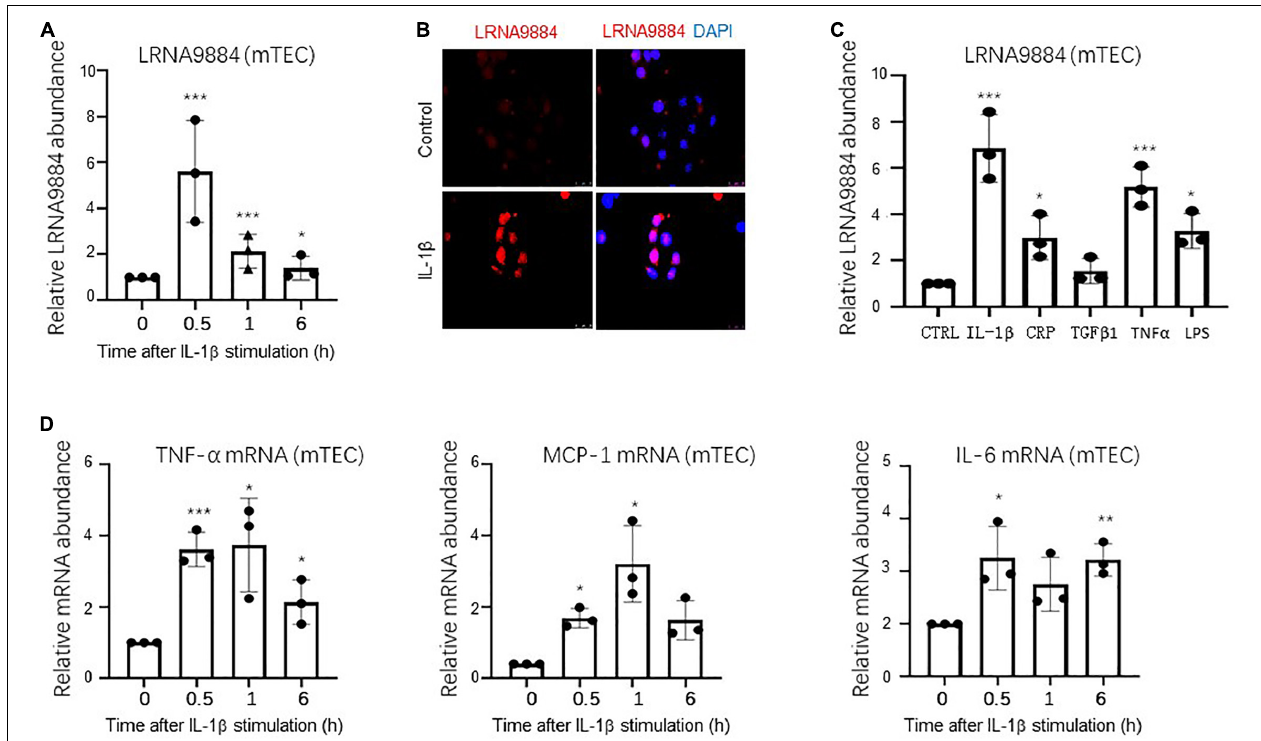
FIGURE 2 | IL-1 β triggers LRNA9884 and inflammation cytokines in mTECs. (A) Real-time PCR showed that IL-1 β (10 ng/ml) induced LRNA9884 expression in mTECs in a dose-dependent manner. (B) FISH assay detected an increase in LRNA9884 expression after IL-1 β treatment, primarily localized in the nucleus of mTECs. (C) Real-time PCR shows LRNA9884 expression after IL-1 β , CRP, TGF- β , TNF α , and LPS treatment in mTECs. (D) Real-time PCR shows TNF- α , MCP-1 and IL-6 expression after IL-1 β treatment. Bars represent the mean ± SEM for at least three independent experiments. * P < 0.05, ** P < 0.01, *** P < 0.001 vs. time 0